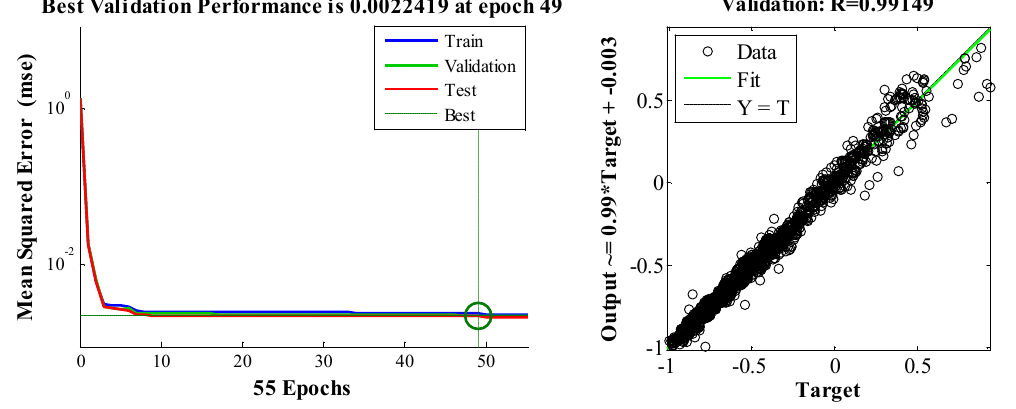
Figure 8. Mean squared error vs. training epochs and regression plot.